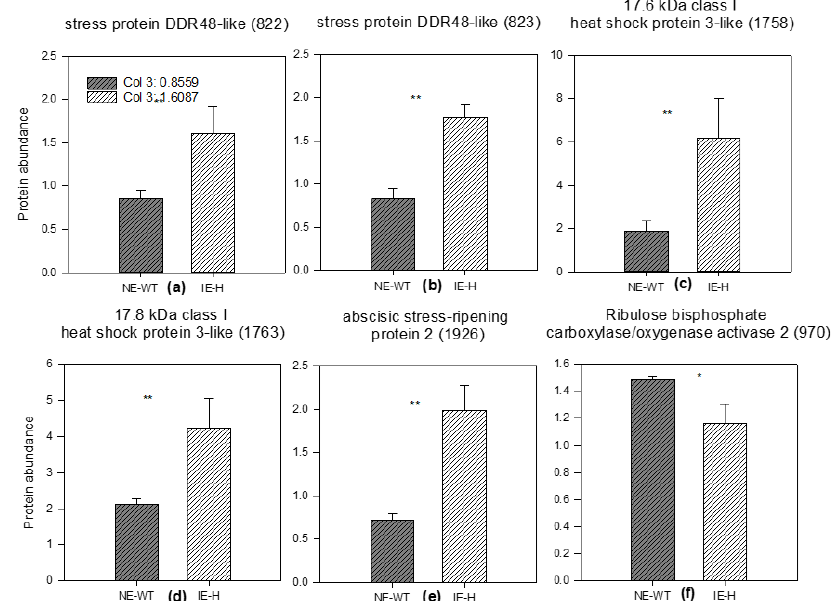
Figure 6. Different abundance of proteins in water-stressed conditions in actual climate. The abun- dances of stress protein DDR48-like (822, 823) ( a , b ), 17.6 kDa class I heat shock protein 3-like (1758) ( c ), 17.8 kDa class I heat shock protein-like (1763) ( d ), abscisic stress-ripening protein 2 (1926) ( e ) and Rubisco activase 2 (970) ( f ) are reported in severely water-stressed plants (at T3). Grey-striped bars show non-emitting wild-type = NE-WT, and white-striped bars are isoprene-emitting line = IE-H. Means ( n = 3) + SE are shown. A S tudent’s T -test was performed to define the statistical signifi- cance (* p < 0.05; ** p < 0.01) of differences in the abundance of proteins between genotypes.